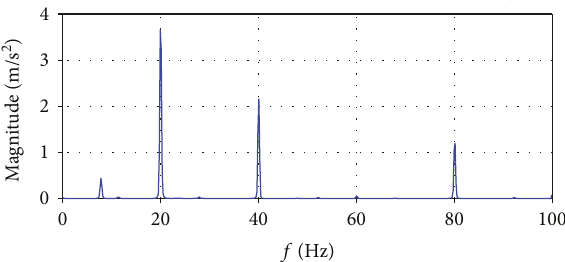
Figure 30: D5, direct response FFT, 20Hz sine